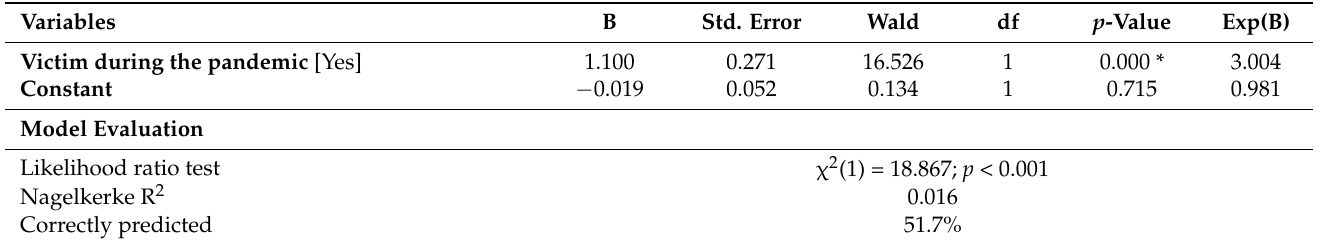
Table 4. Model 3—Victimization effect on the lockdown social impacts’ profiles.